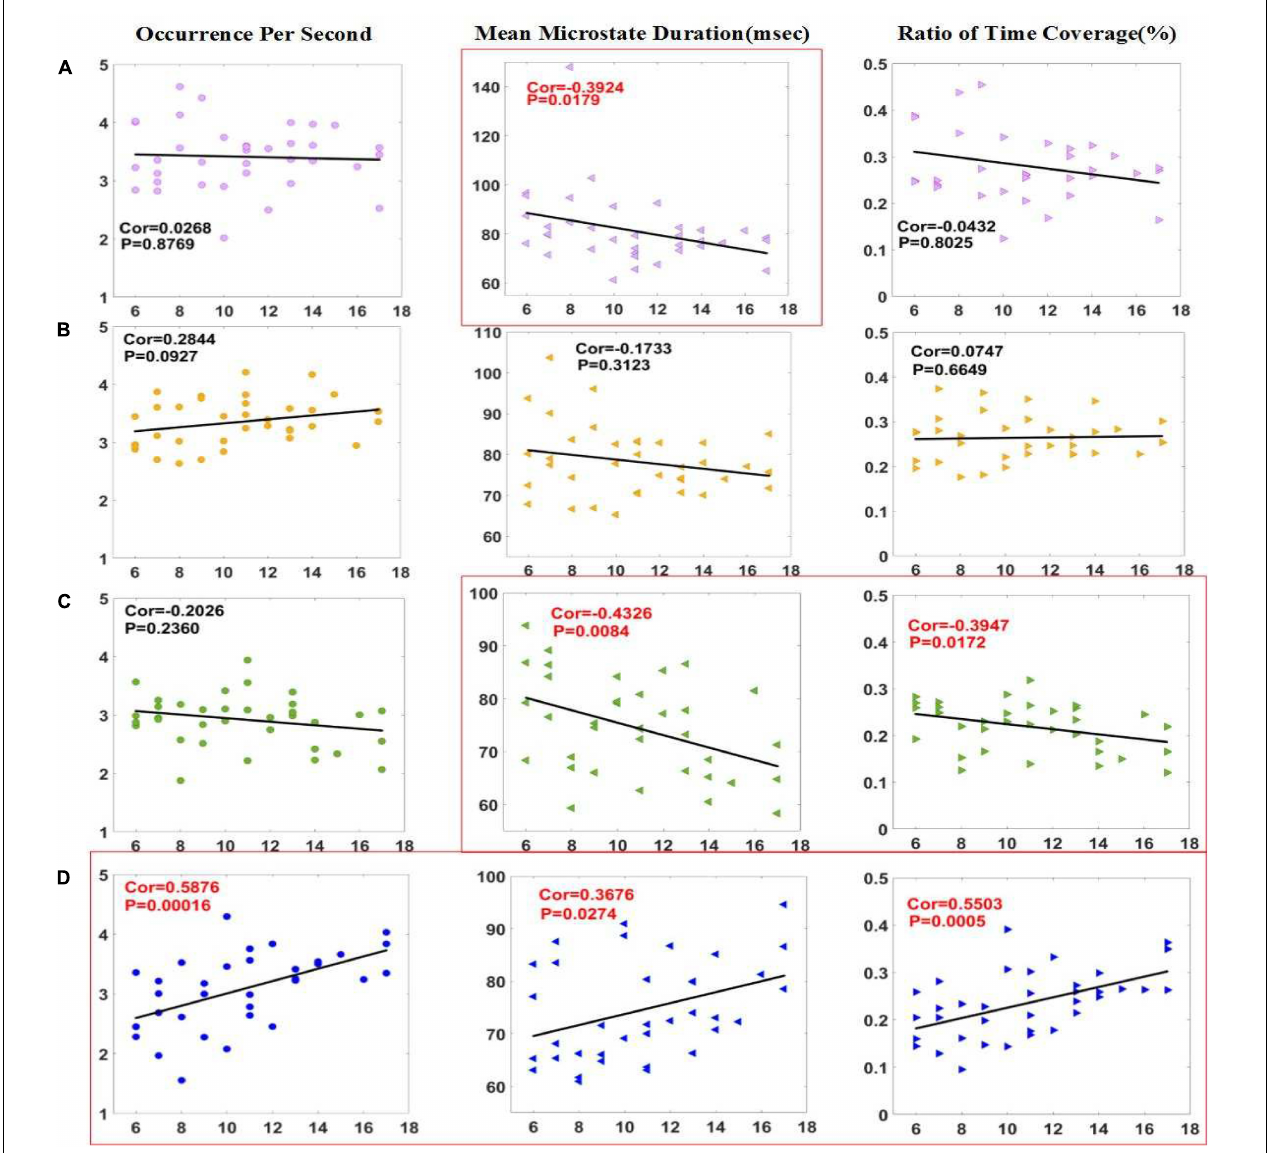
FIGURE 3 | Correlation between parameters of microstate (A–D) and CRS-R scores in the improved group. Pearson correlation analysis was performed between the microstate parameters of patients with DOC and CRS-R scores in improved group. The MMD of microstate A and the MMD and Cov of microstate C were negatively correlated with CRS-R scores, and the three parameters of microstate D were positively correlated with CRS-R scores. Significant correlations ( p < 0.05) were indicated in red and circled in